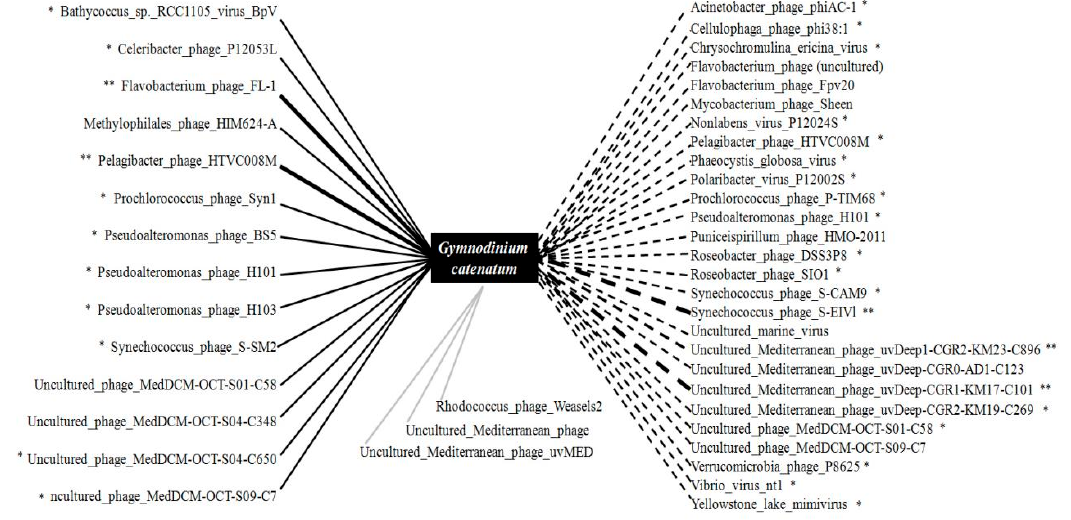
Figure 5. Correlation analysis of the relationship between the representative virus and the target algae G. catenatum . There was a total of forty-four correlations (fourteen positive, twenty-seven negative, and three unconnected). The solid lines indicate positive correlations, and bold solid lines indicate strong, negative correlations. The dotted lines indicate negative associations, and the bold dotted lines indicate strong negative associations. The grey solid lines indicate unlinked relationships. The statistical significance levels are * p < 0.05 and ** p <